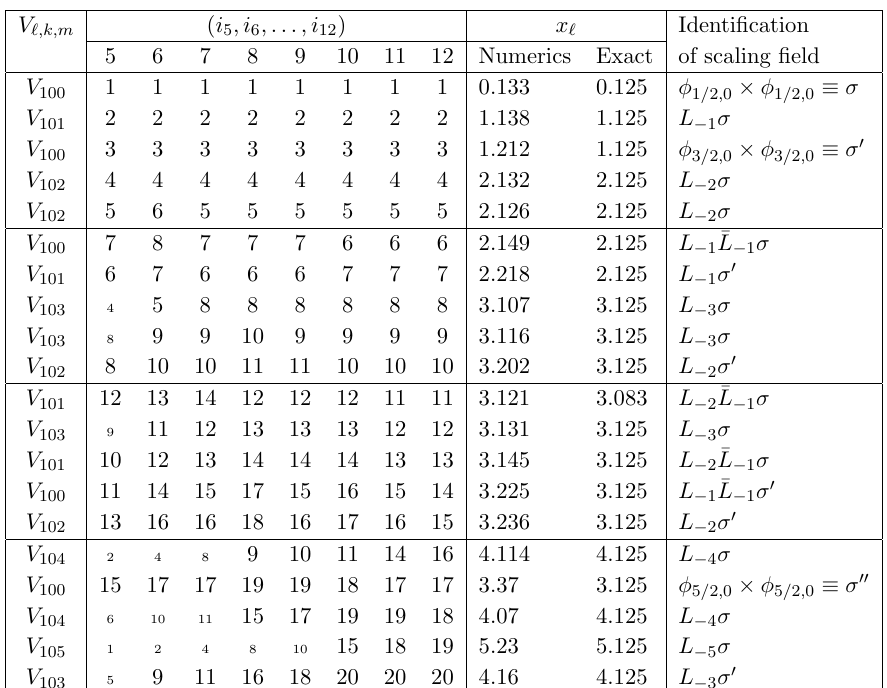
Table 4 . Conformal spectrum in the sector V 0 , for Q = 4.